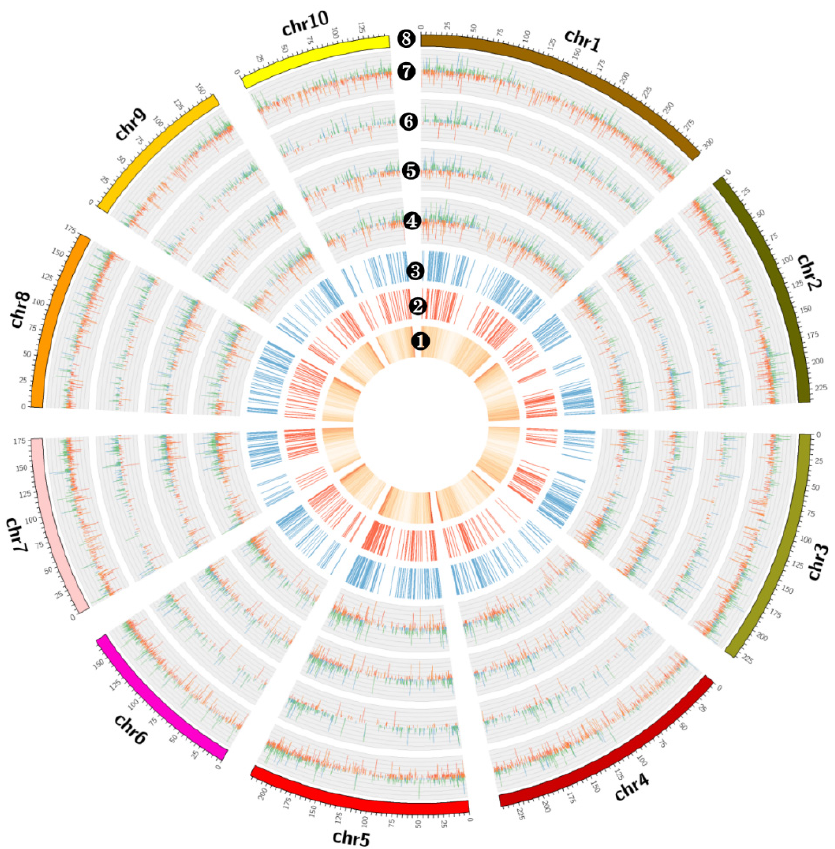
Figure 4. Circular plot of DEG distribution of two inbred lines. The circular plots from the inner to outer layer are ❶ Gene frequency in 1-Mb windows of the whole genome, ❷ Common DEG frequency in multiple timepoints of S8 in 1-Mb windows of the whole genome, ❸ Common DEG frequency in multiple timepoints of R6 1-Mb windows of the whole genome, ❹ log2FC (fold change) of DEGs identified from two inbred lines in 240 h. ❺ log2FC of DEGs identified from two inbred lines in 144 h. ❻ log2FC of DEGs identified from two inbred lines in 24 h. ❼ log2FC of DEGs identified from two inbred lines in 6 h. ❽ Chromosome length. In ❹ – ❼ , the red bars are log2FC of up-regulated DEGs from R6, the blue bars are log2FC of downregulated DEGs from R6, the orange bars are log2FC of upregulated DEGs from S8, the green bars are log2FC of downregulated DEGs from S8.